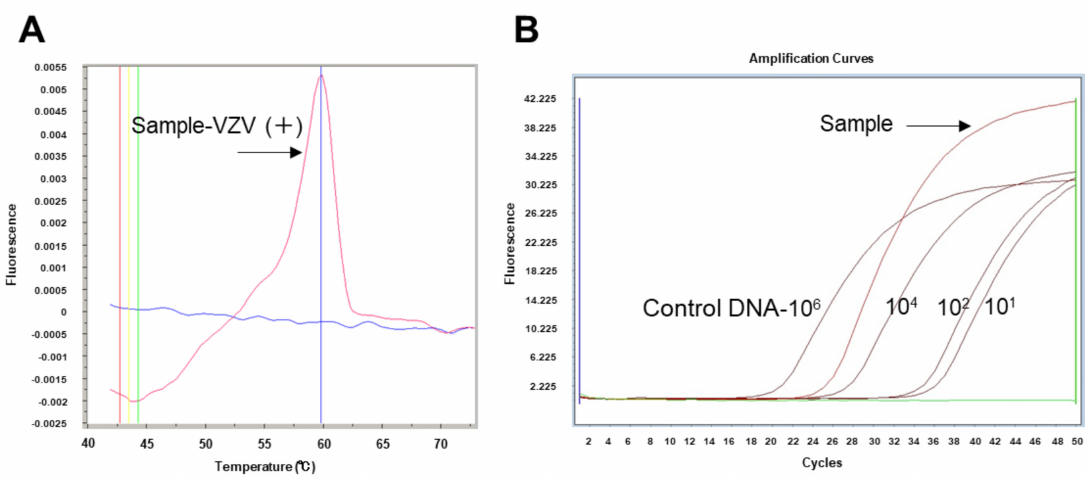
Figure 1. Representative results of a VZV-positive vitreous fluid sample (No. 11) analyzed using the combination PCR system. ( A ) Representative result of VZV-positive VF sample by qualitative multiplex PCR. After DNA extraction from the VF sample, multiplex PCR was performed to screen for viruses using LightCycler capillaries. At 60 ◦ C, a significant positive curve was detected, indicating the detection of VZV-DNA in the sample. At the same time, other HHVs such as HSV type 1, type 2, and CMV were confirmed to be negative for this sample. ( B ) Representative result of the same VZV-positive VF sample analyzed by quantitative real-time PCR (qPCR). The VZV genome copy number in the sample was calculated. The VF sample and control DNA (1.0 × 10 6 , 10 4 , 10 2 , and 10 1 copies / mL) by